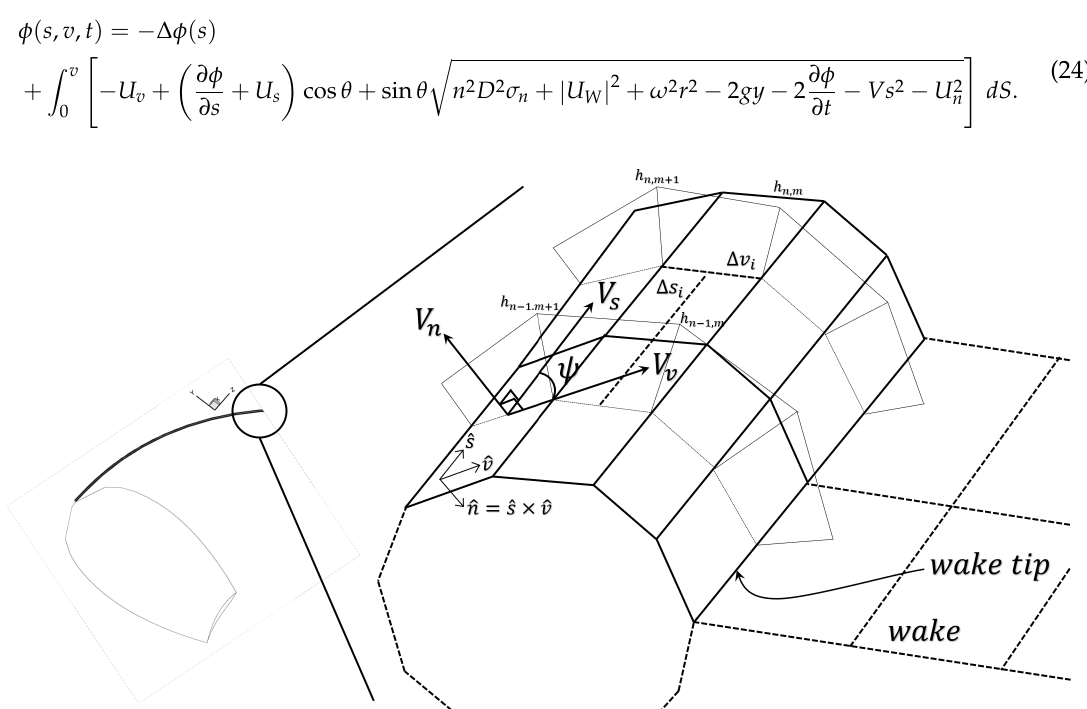
Figure 6. Schematics showing directions of the local velocities in s , v , and n directions on the curvilinear coordinate system. Integral in Equation (24) is computed along the positive v direction from the M th panel which is attached to wake